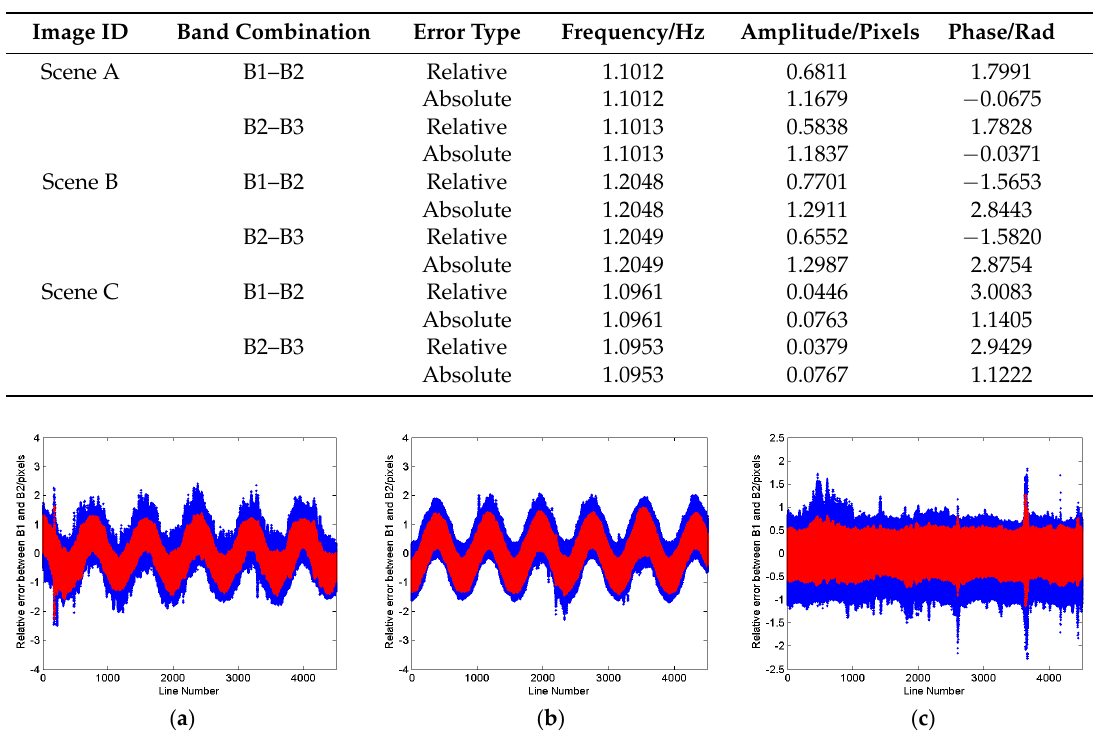
Table 11. Results of the conventional method.